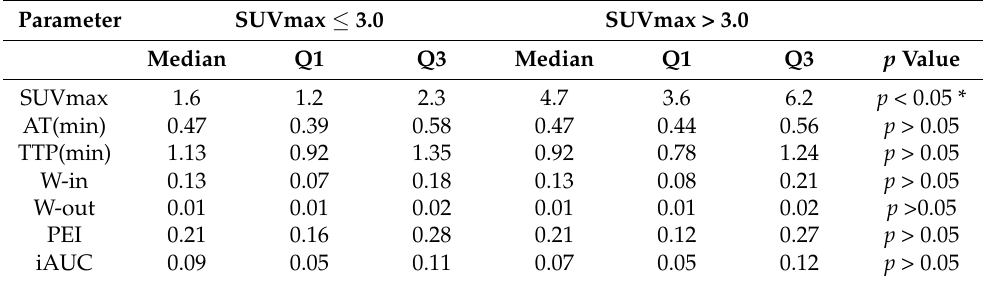
Table 2. Comparison of parameters between benign lesions with SUVmax ≤ 3.0 and SUVmax > 3.0. Parameter